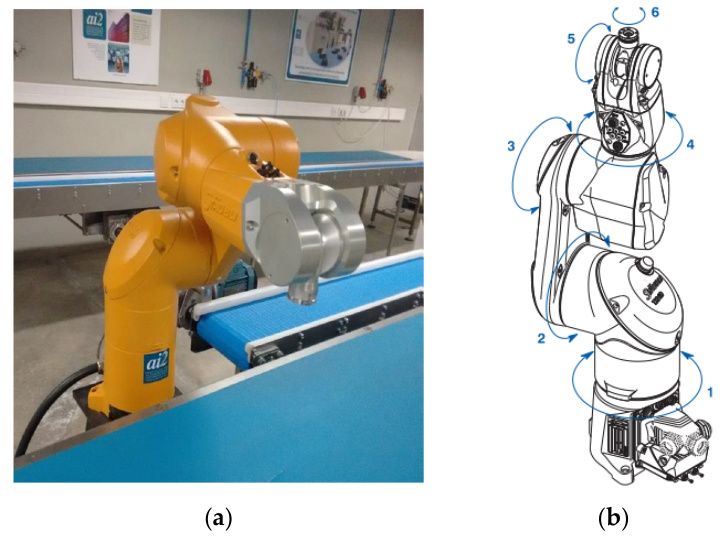
Figure 1. Robot Stäubli TX60. ( a ) robot arm in the lab; ( b ) degrees of freedom scheme.